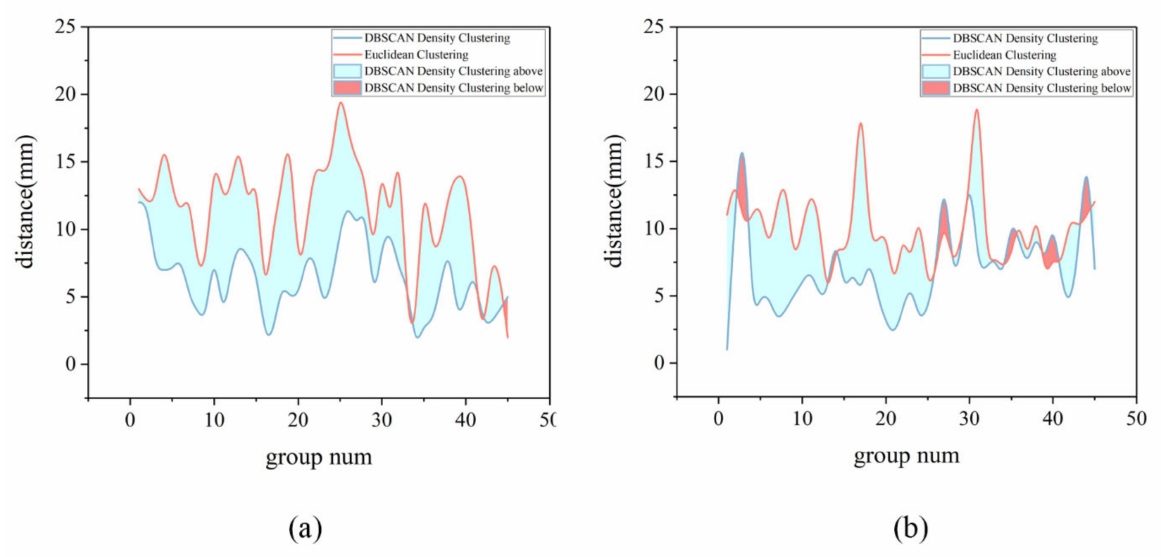
Figure 14. Experimental results: ( a ) horizontal; ( b ) diagonal at 45